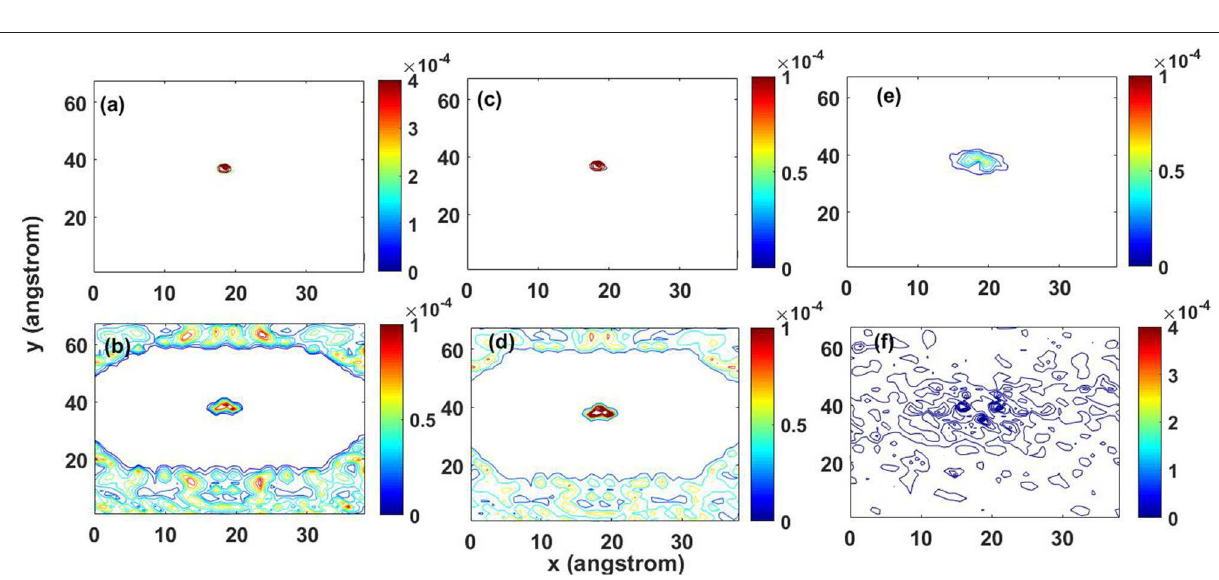
FIGURE 6 | Power spectral density of kinetic energy of the central atom in the graphene lattice for the (A) harmonic, (B) anharmonic, and (C) Tersoff potentials.